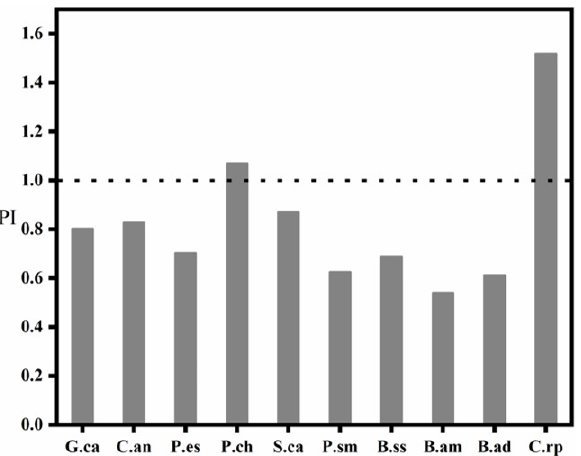
Figure 6. Trace Metal Pollution Index of the fish from Wulungu